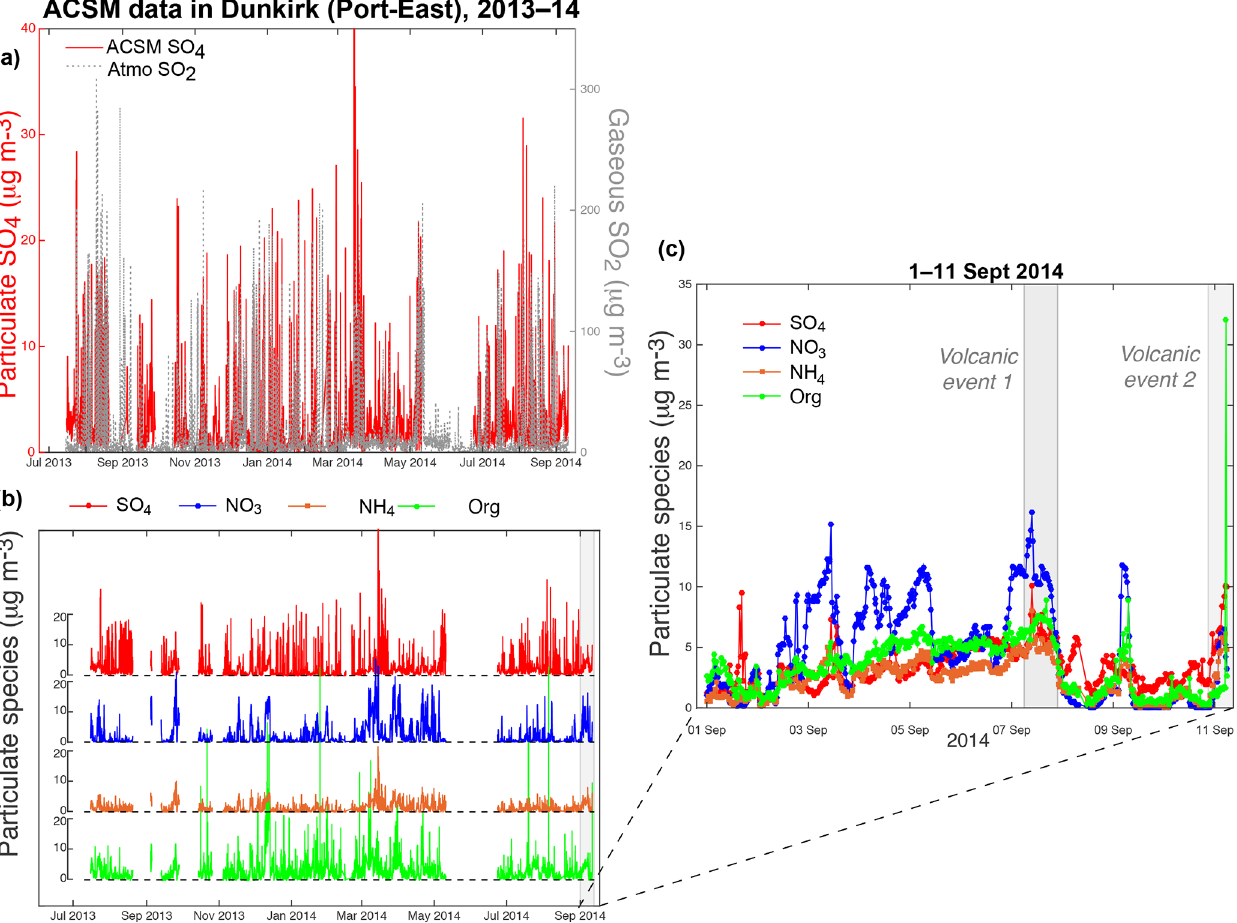
Figure 3. (a, b) 14-month long time series of (a) (left red) particulate SO 4 (ACSM), (right grey) gaseous SO 2 (Atmo Hauts-de-France air quality station) and (b) ACSM species (sulfate (SO 4 ), nitrate (NO 3 ), ammonium (NH 4 ) and organic (Org) aerosols) mass concentrations from 15 July 2013 until 11 September 2014, at Dunkirk Port-East station. (c) Focus on the period 1–11 September 2014 when events of air pollution induced by the Holuhraun eruption were